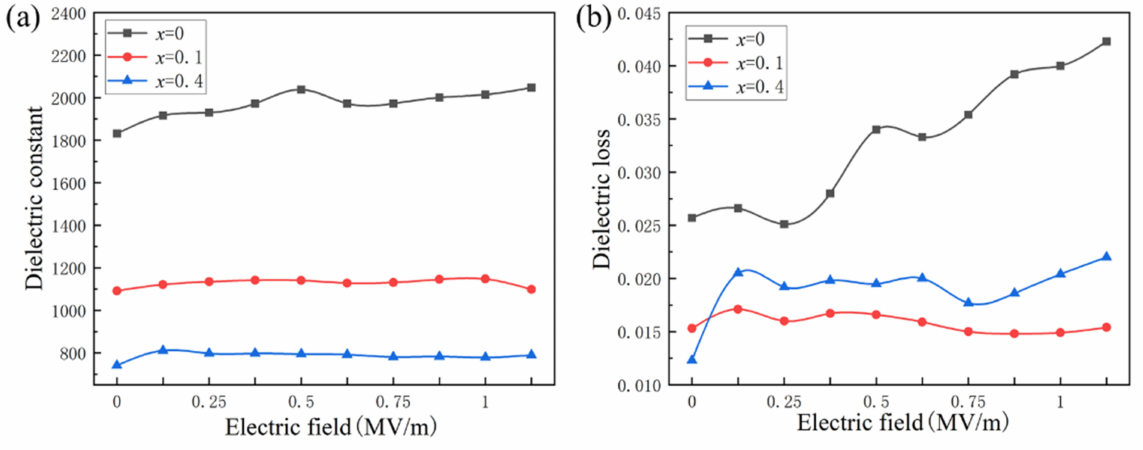
Figure 4. ( a ) Dielectric constant and ( b ) dielectric loss of Ba 1 − x Ca x TiO 3 ( x = 0, 0.1, 0.4) ceramics polarized at different electric fields at 20 ◦ C and measuring frequency of 100